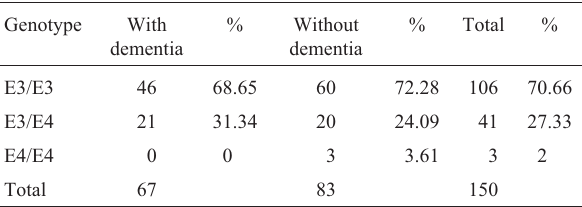
Table 1 - ApoE genotype frequencies in elderly Saudi subjects with and without dementia. Genotype